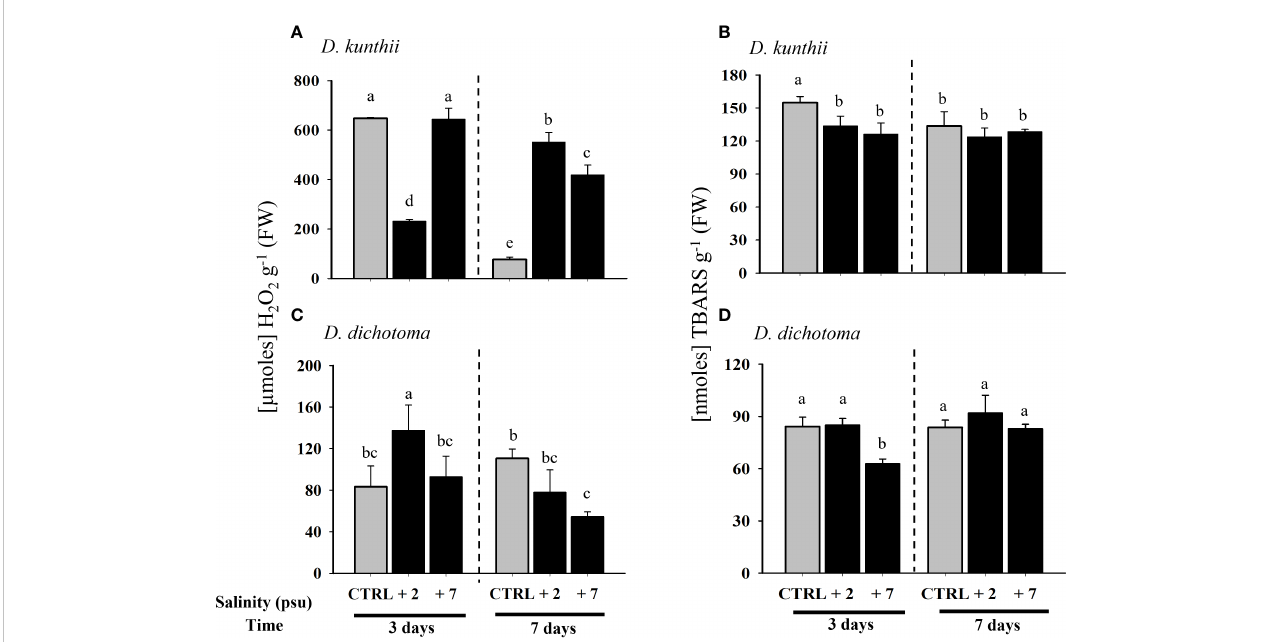
FIGURE 4 Concentration of H2O2 and thiobarbituric acid reactive substance in D. kunthii (A, C) and D. dichotoma (B, D) exposed to high salinity values. For D.kunthii , the salinity values were 35 psu (control), 37 (+2) psu, and 42 (+7) psu; for D. dichotoma , these were 37 psu (control), 39 (+2) psu, and 44 (+7) psu. The samples were analyzed after 3 and 7 days. Data corresponds to mean ± SD (n = 3). Letters represent statistical difference at 95% con fi denceinterval (Student – Newman – Keuls test, p < 0.05).